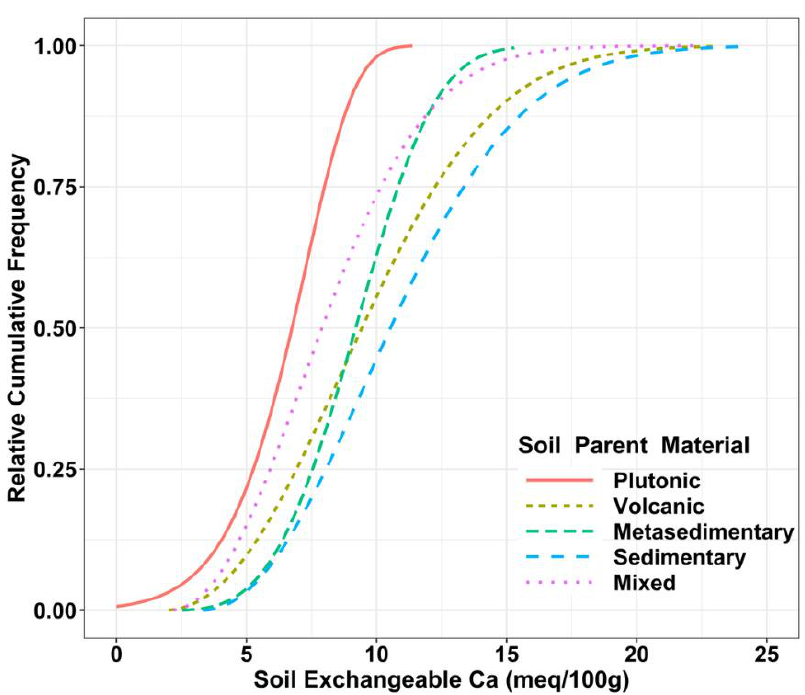
Figure 4. Soil exchangeable magnesium cumulative distributions for different bedrock soil parent materials in the Inland Northwest, USA.